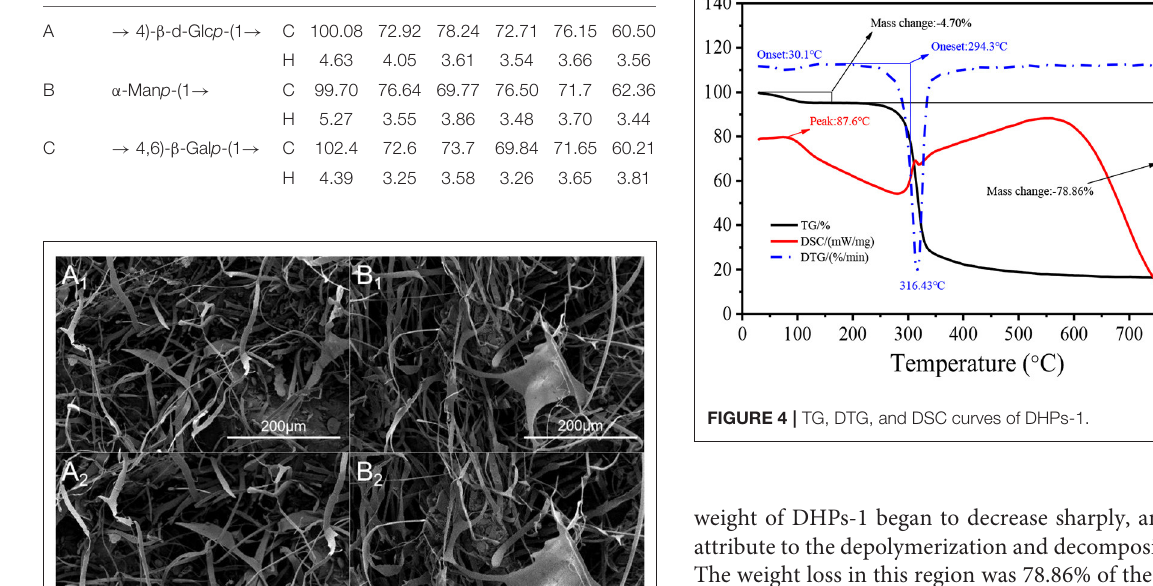
TABLE 5 | 1 H and 13 C NMR chemical shifts of DHPs-1 recorded in D 2 O. Sugar Residues